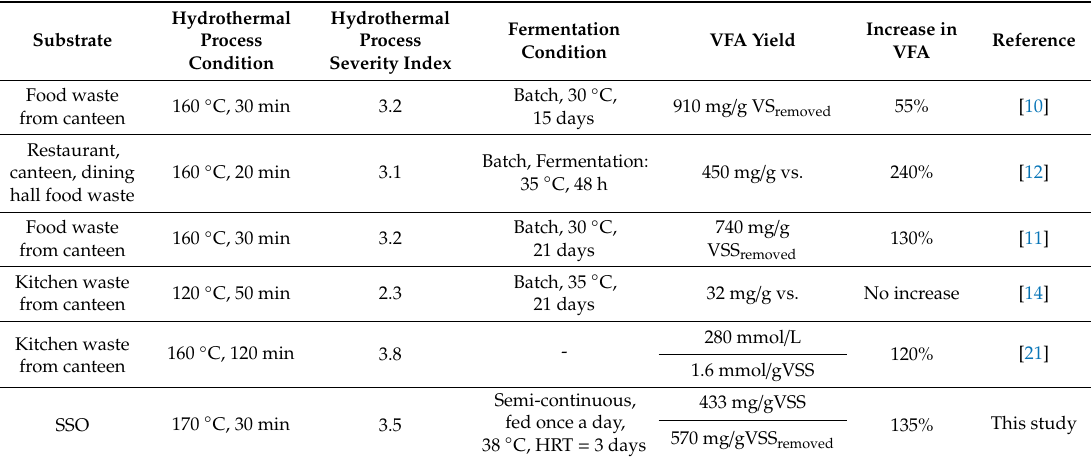
Table 1. Comparison of VFA yield in this study to